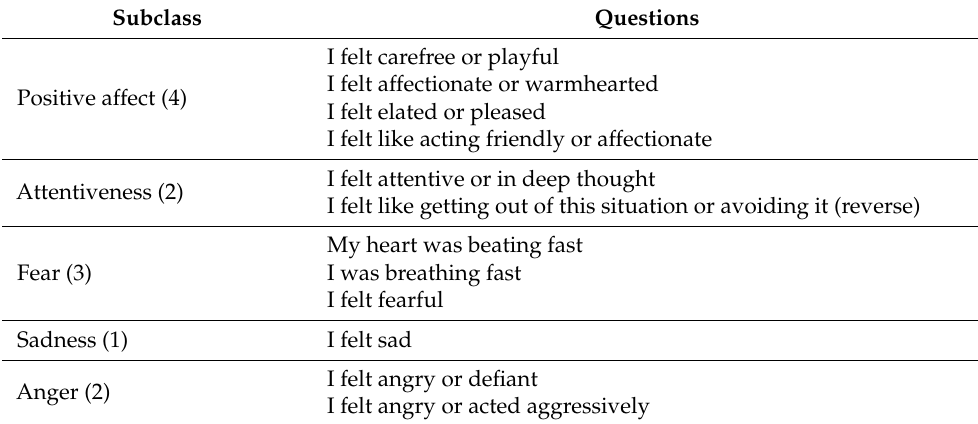
Table 1. Zuckerman inventory of personal reaction scale (ZIPERS) subclass and